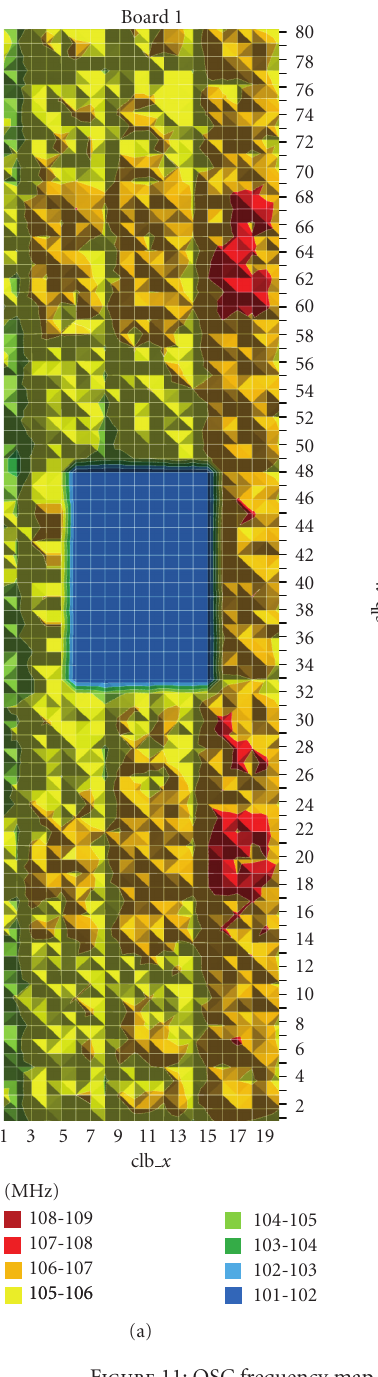
Figure 11: OSC frequency map (MHz) board 1/board